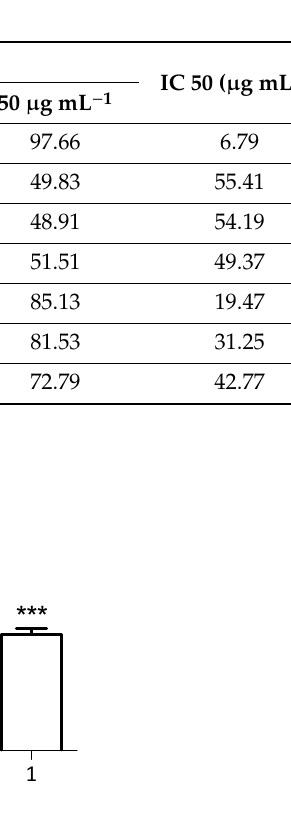
Figure 7. Antioxidant activity of methanol: water extracts of saffron in mock and SA treated cells intra (cells) and extracellularly (spent medium) measured by; ( a ) Oxygen radical absorbance capacity (ORAC); ( b ) Trolox equivalent antioxidant capacity (TEAC) assays. Common letter in each group indicates no significant differences ( p < 0.05). Table 1. Inhibition percentage (I %) and IC50 (µg mL − 1 ) of free radical scavenging activities from DPPH assay in saffron mock and salicylic acid (SA) treated cells at different concentrations of both cell extracts and their spent media.